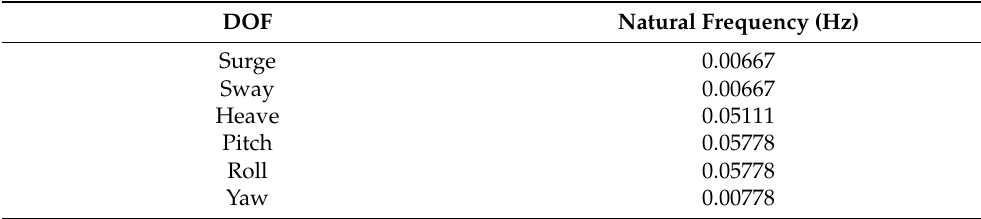
Figure 10. Free decay motions of the integrated system in six DOFs. Table 7. Natural frequencies of the integrated system in six